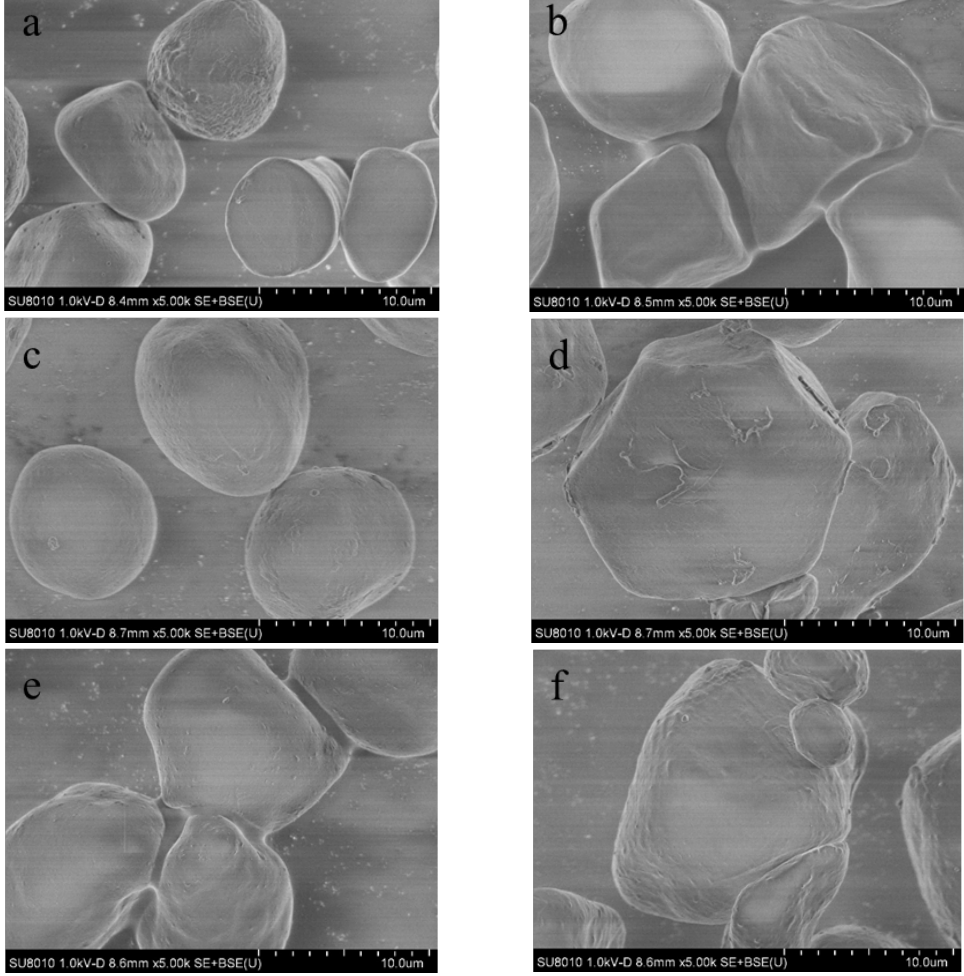
Figure 4. Surface morphology of several pretreated blend powder samples observed using SEM: ( a ) pure starch, ( b ) PSt, ( c ) PLA/PSt, ( d ) PLA/PSt/PEG, ( e ) PLA/PSt/CA, and ( f )